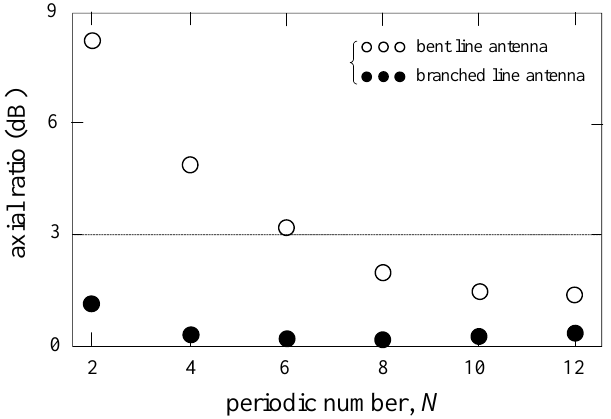
Figure 4. Simulated axial ratio versus periodic number N .